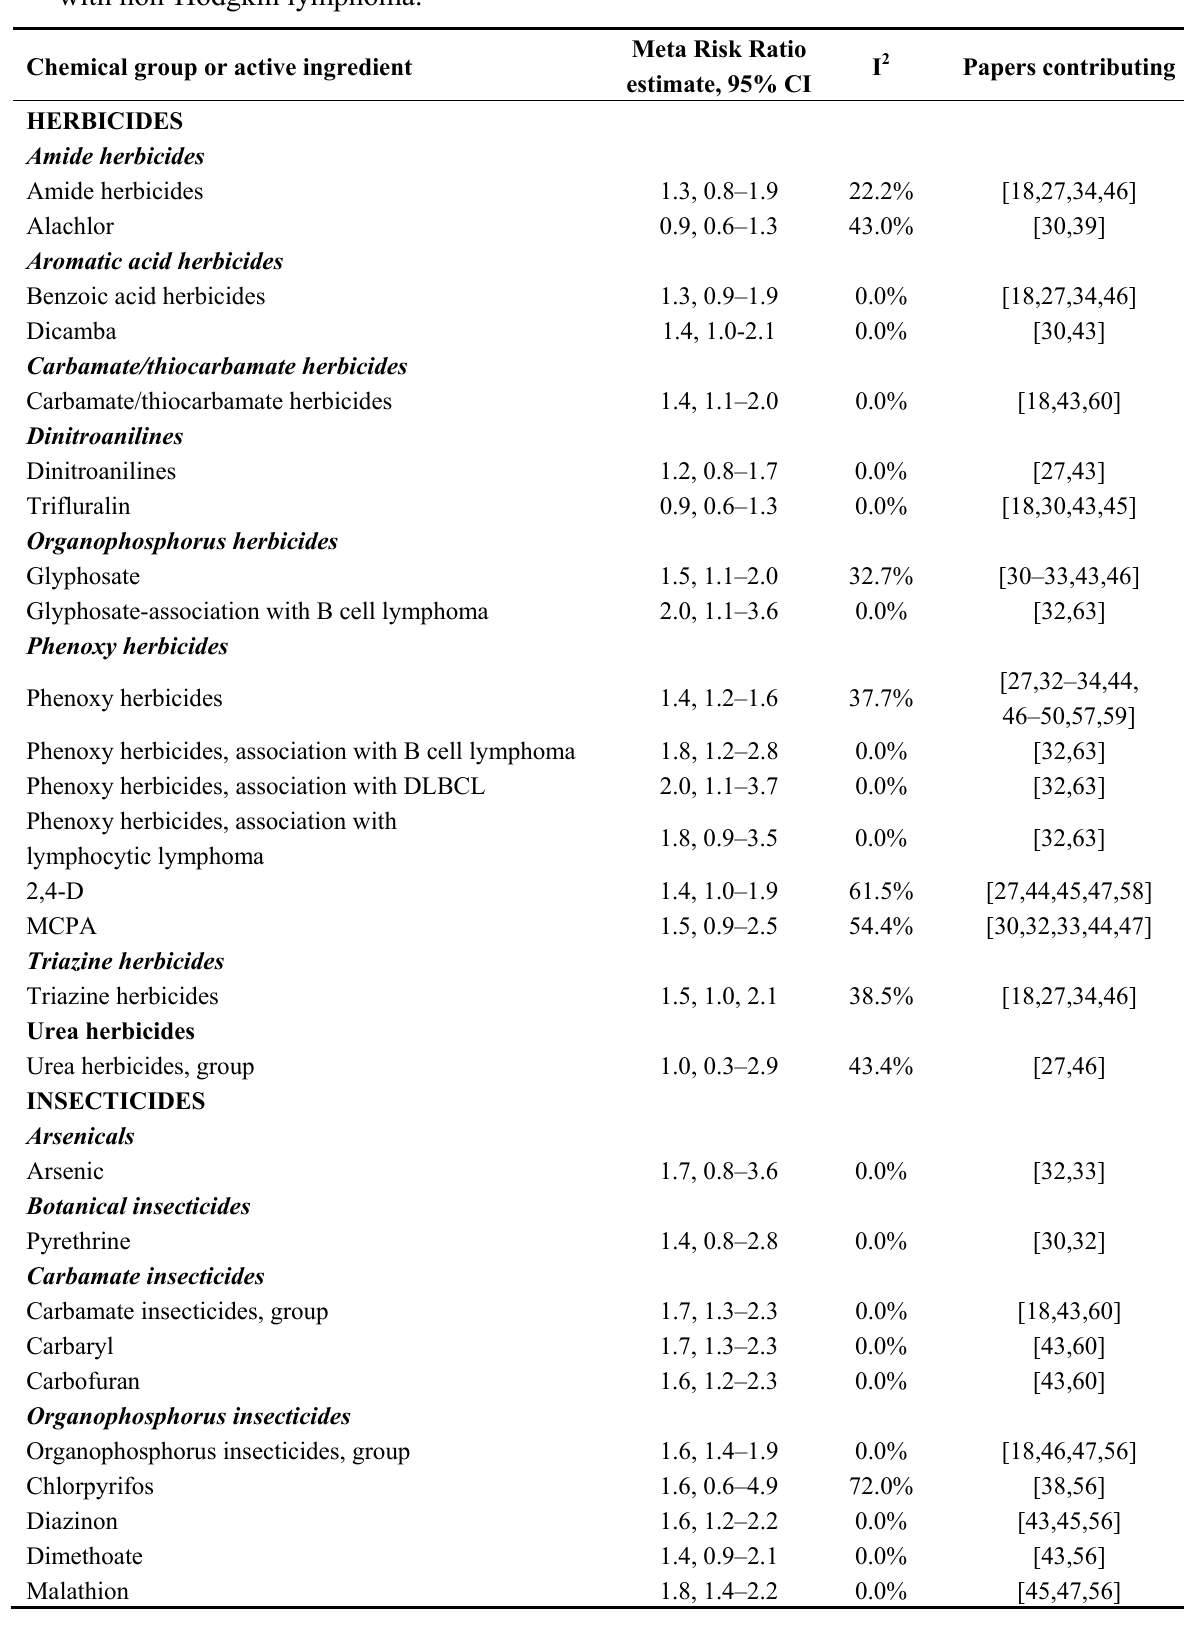
Table 5. Meta analytic summary estimates of association between herbicides and insecticides with non-Hodgkin